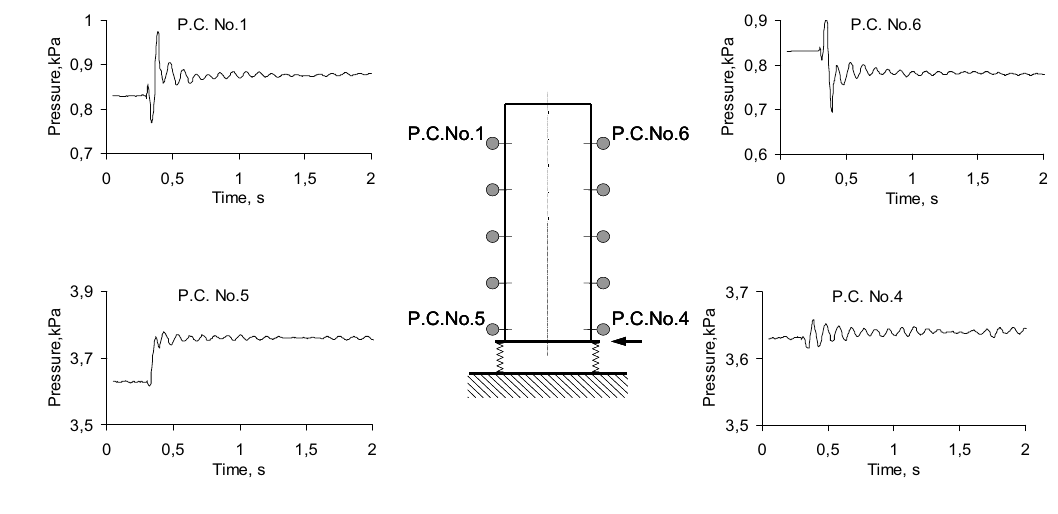
Fig. 5. Time histories of pressures for series